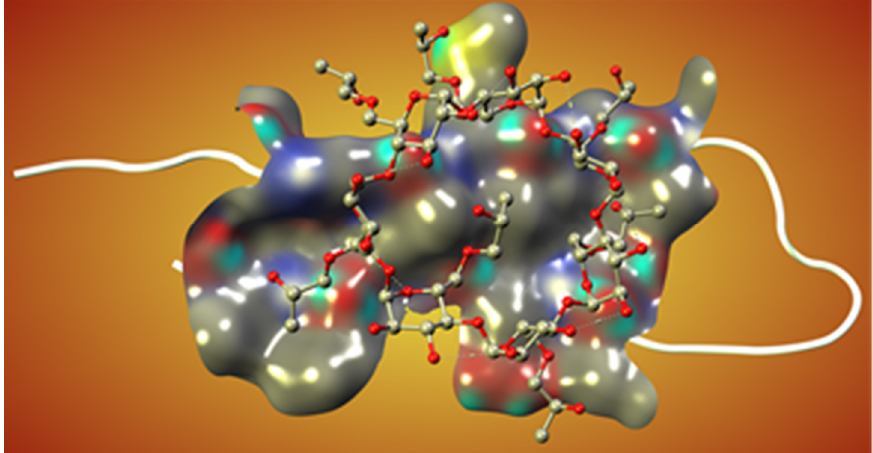
Figure 4. The predicted interaction of the HPβCD molecule with Aβ as a monomer. The monomer is depicted in white, and the cyclodextrin is shown as a ball-and-stick model. The molecular surface represents the interaction between protein and ligand structures (Shityakov et al., unpublished).